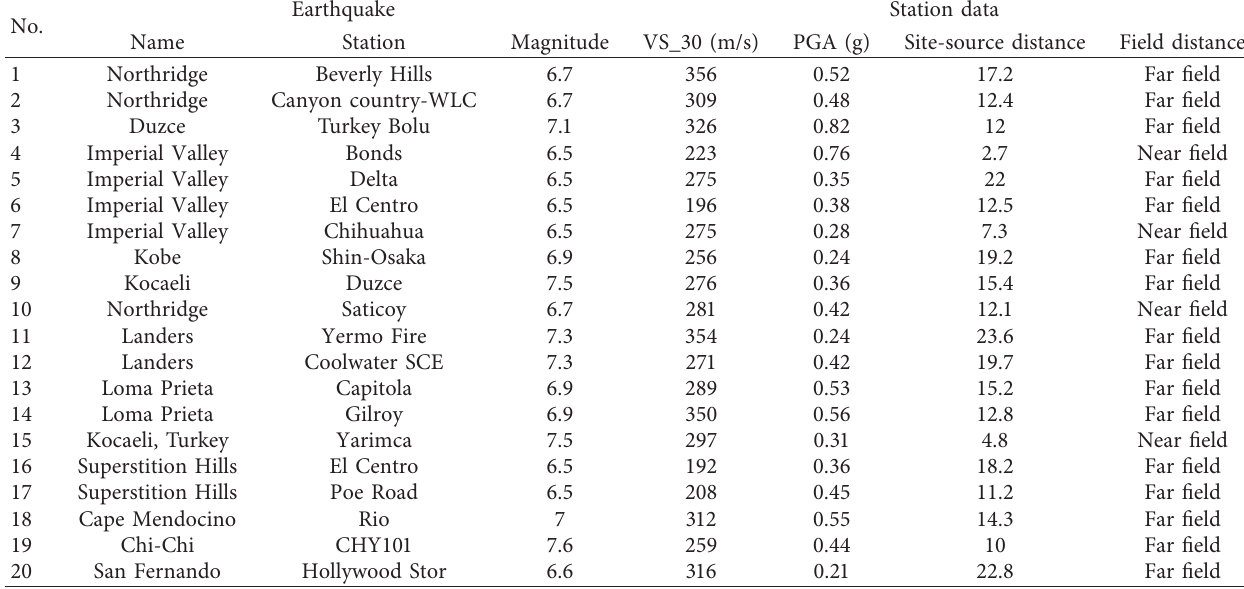
Table 2: Selected records for incremental dynamic analysis.